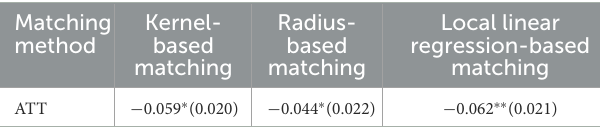
TABLE 3 Endogenous test and robustness test results.